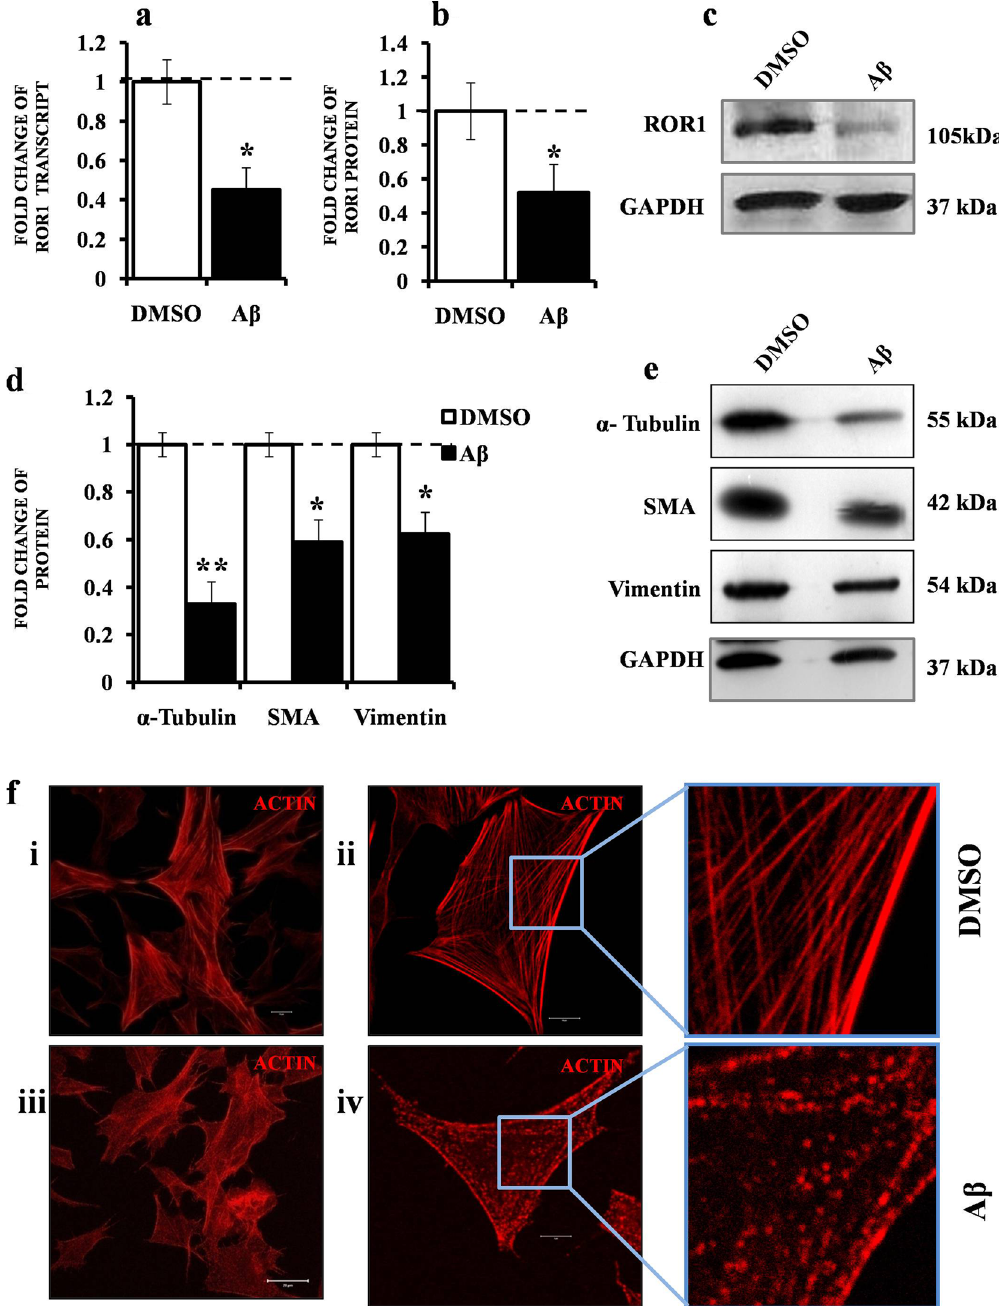
Figure 1. Deregulation of ROR1, key signalling proteins and actin cytoskeleton in Aβ 1–42 treated cell model. ( a ) Graph depicting three (n = 3) independent biological replicates quantifying levels of ROR1 by qRT-PCR in SHSY-5Y cells treated with 1 µM Aβ 1–42 or treated with only DMSO. ( b ) Graph depicting the mean value of optical density of the ROR1 bands, normalized against GAPDH. ( c ) Western blot (n = 3) showing the ROR1 and GAPDH levels in Aβ 1–42 treated cell model. ( d ) Graph depicting the mean value of optical density of the α-Tubulin, SMA and Vimentin bands, normalized against GAPDH. ( e ) Western blot (n = 3) showing the α-Tubulin, SMA, Vimentin and GAPDH levels in Aβ 1–42 treated cell model ( f ). Confocal microscopy images of phalloidin-561 (actin) stained SHSY-5Y cells; DMSO treated (Panel i. 1X zoom), DMSO treated (Panel ii. and inset. 3X zoom), Scale bars, 5 μm; Aβ 1–42 treated (Panel iii. 1X zoom), Aβ 1–42 treated (Panel iv. and inset. 3X zoom), Scale bars, 5 μm; For each confocal experiment, images of at least 30 cells (or cell fields) were captured and the experiments were repeated thrice (n = 3). Error bars indicate ± SD. Significance level between different experimental pairs is shown (NS, not significant; * p < 0.05; ** p < 0.01; *** p <